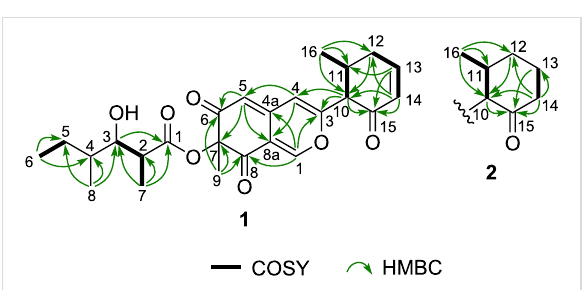
Figure 2: Key HMBC (green arrows) and COSY (bold) correlations in 1 and 2 .